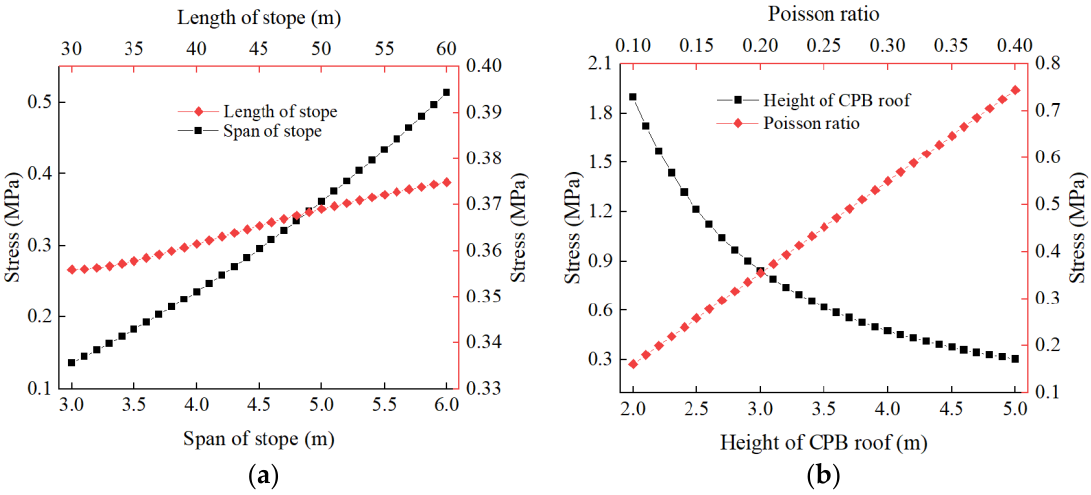
Figure 7. Effect of factors on stress: ( a ) size of the stope, ( b ) parameters of the filling body.